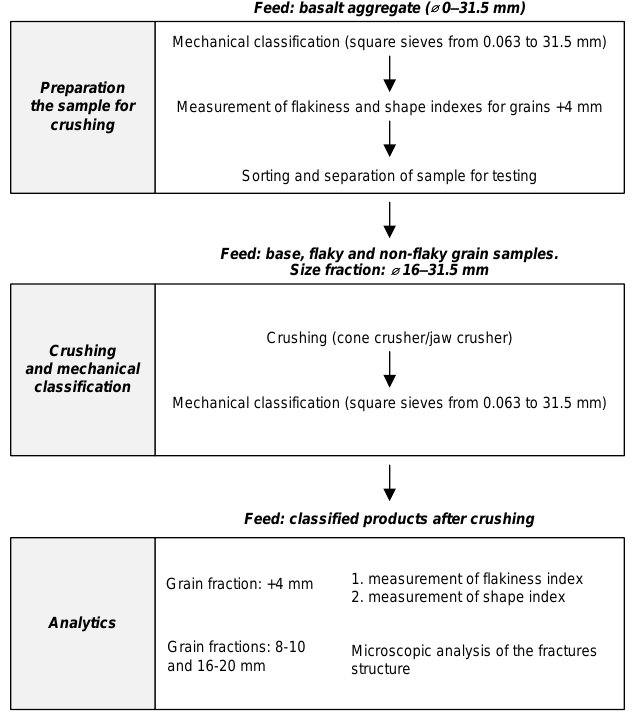
Figure 2. Experimental flowchart of the crushability tests.